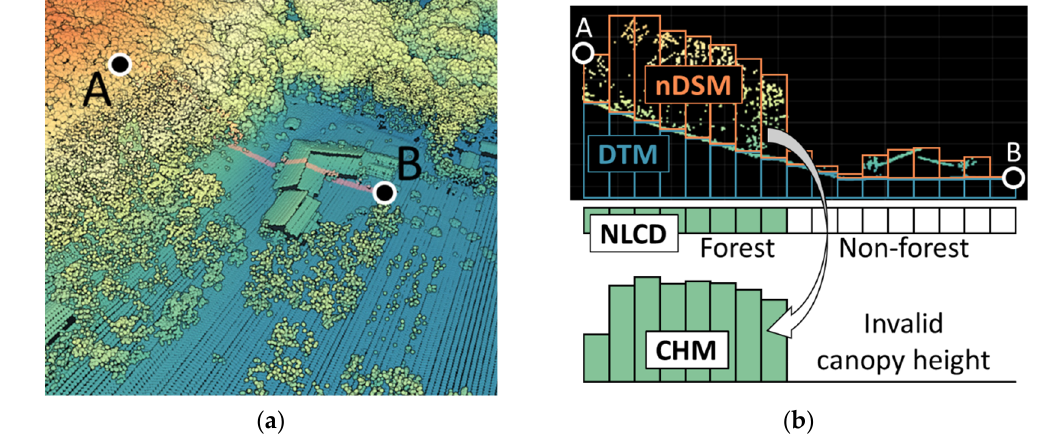
Figure 3. A subset of ( a ) 3D Elevation Program (3DEP) LiDAR data from Martell Forest in Indiana, USA with ( b ) a 2D slice of point cloud along the transect from point A to B showing the canopy height model (CHM) generation procedure. nDSM: normalized digital surface model, DTM: digital terrain model, NLCD: National Land Cover Database-based binary classification map of forested and non-forested areas, and CHM: canopy height model.